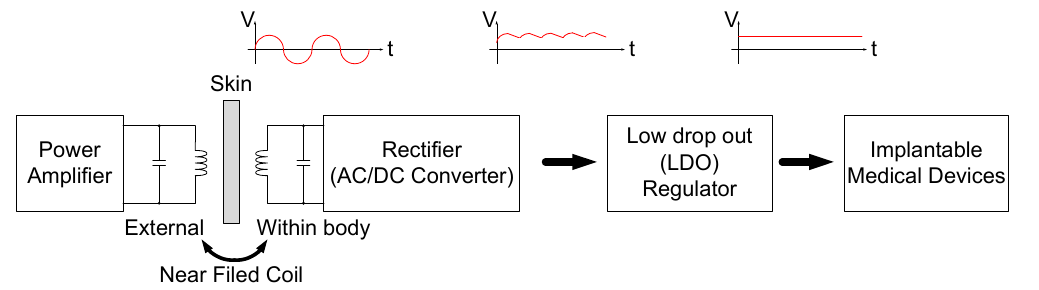
Figure 1. Generic power-combined data transfer system.